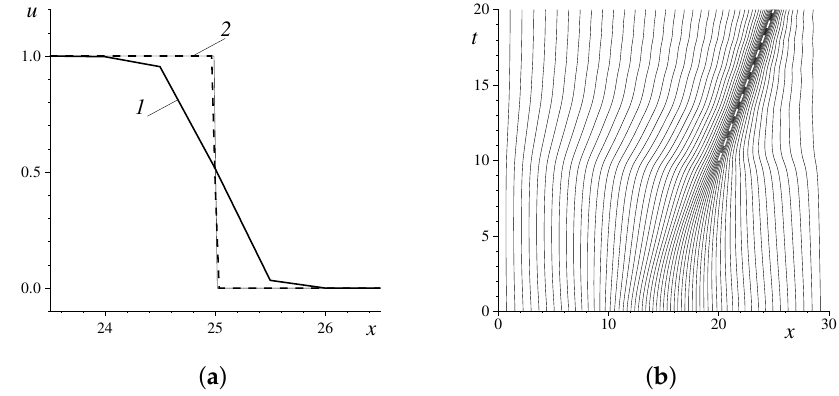
Figure 4. A stationary shock wave formation in the Burgers–Hopf equation: ( a ) A comparison of different profiles (The thin solid line is the exact solution, (1) is the numerical solution on the uniform mesh, and (2) is the solution on the moving mesh); ( b ) the trajectories of grid nodes in space–time. Note that Figure 4a shows only a zoom of the computational